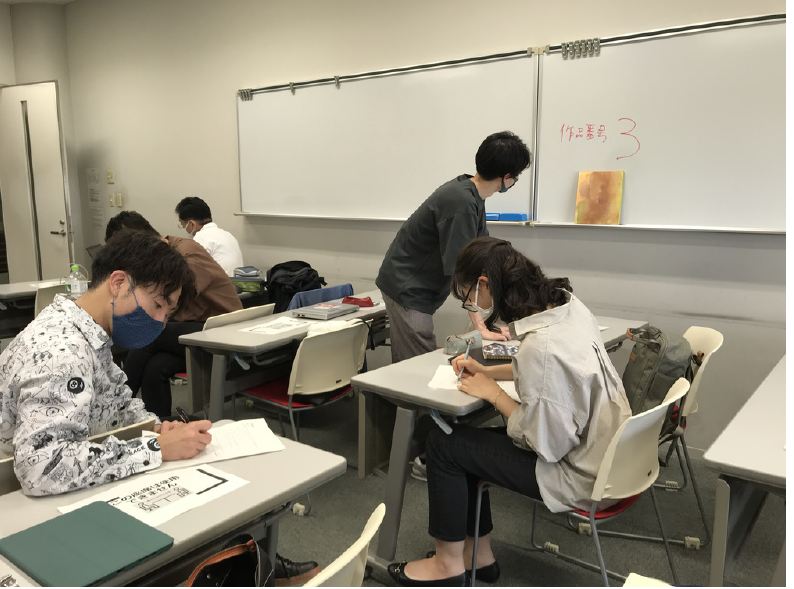
Figure 4. Experiment: using captions with gradually increasing